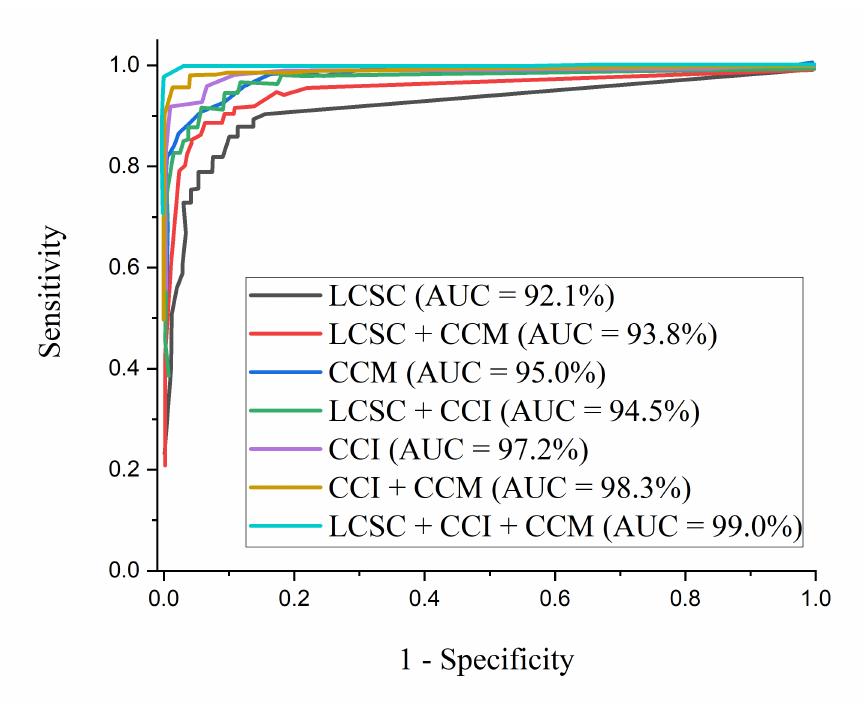
Figure 12. ROC curves for the proposed multi-channel in comparison with the single-channels and dual-channels.